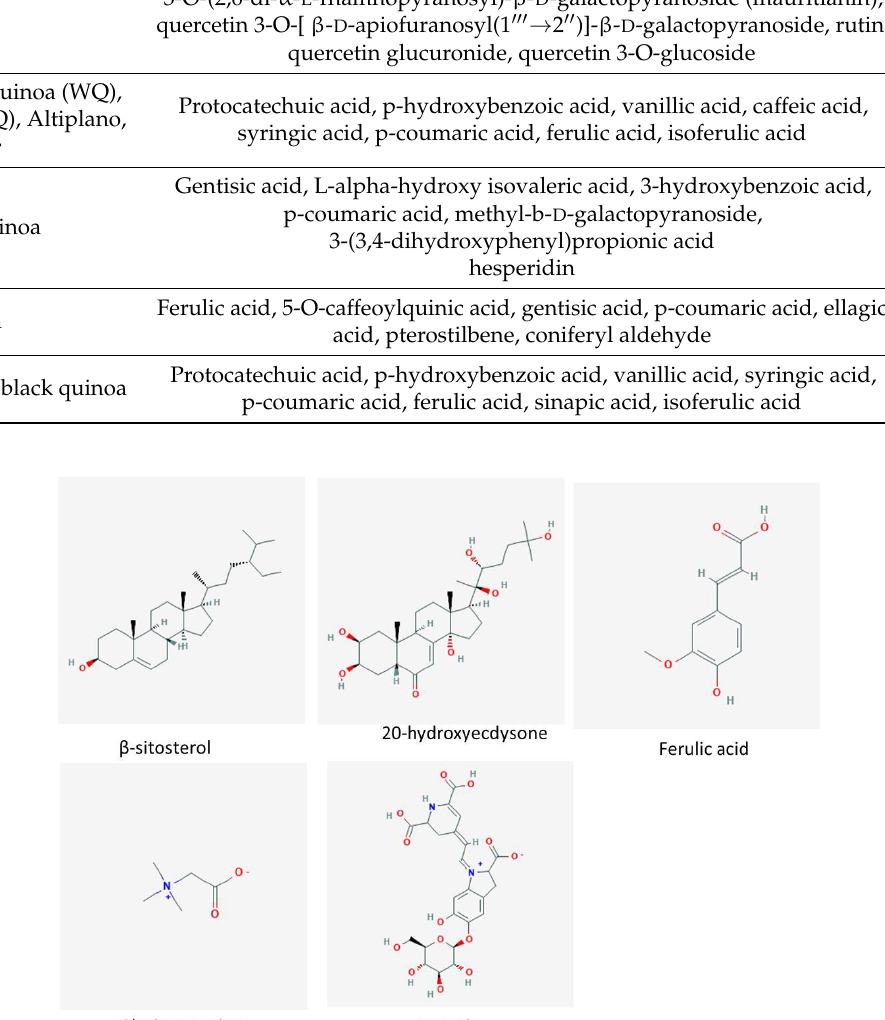
Table 4. Secondary metabolites (flavonoid) identified from different quinoa varieties.